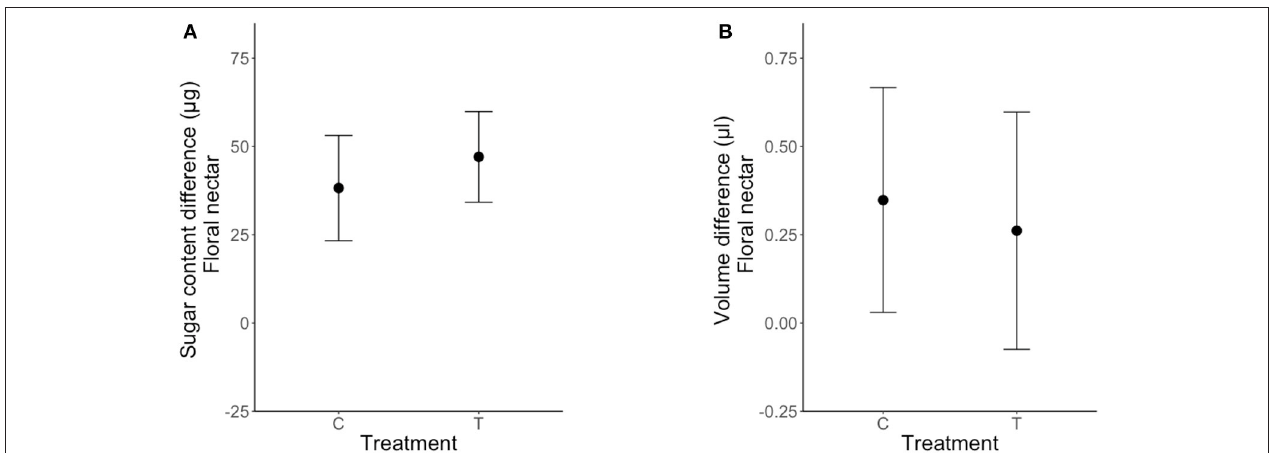
FIGURE 4 | Effect of clogging on nectar secretion and sugar re-allocation in Turnera velutina for nectar volume (A) and sugar content (B), between control (C) and treatment (T) plants (means ± se; n = 50 plants). Values shown are a difference in floral nectar, defined as: [FN post-treatment–FN pre-treatment].